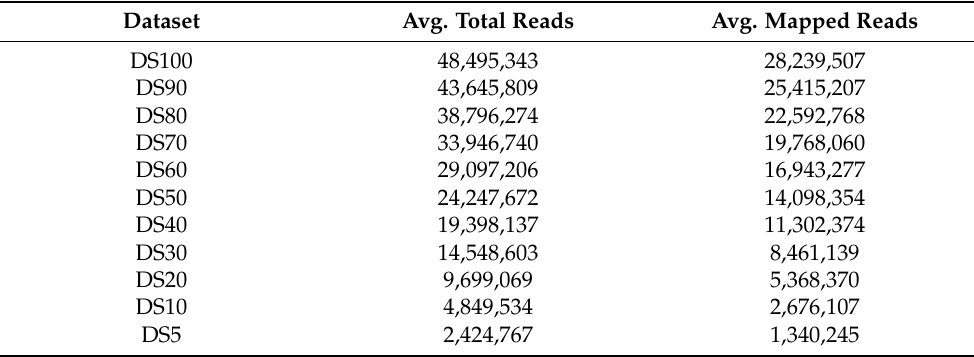
Table 1. The numbers of total and mapped reads are reported for each subset (DS90–DS5) and the total dataset (DS100). The numbers of mapped reads for the subsets are the average among 10 randomly picked replicated subsets with the same size (CV < 0.8%).